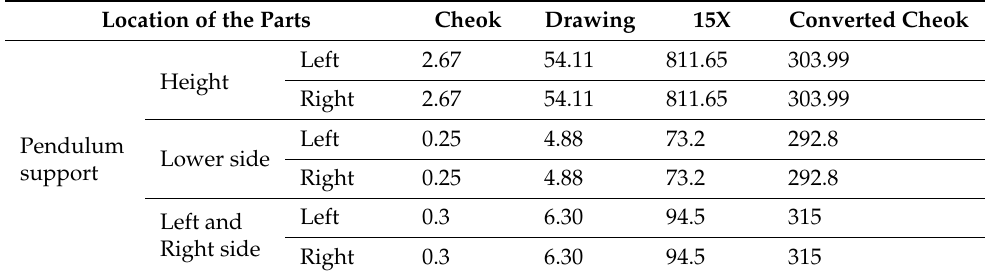
Table 4. Comparison of pendulum support dimensions.